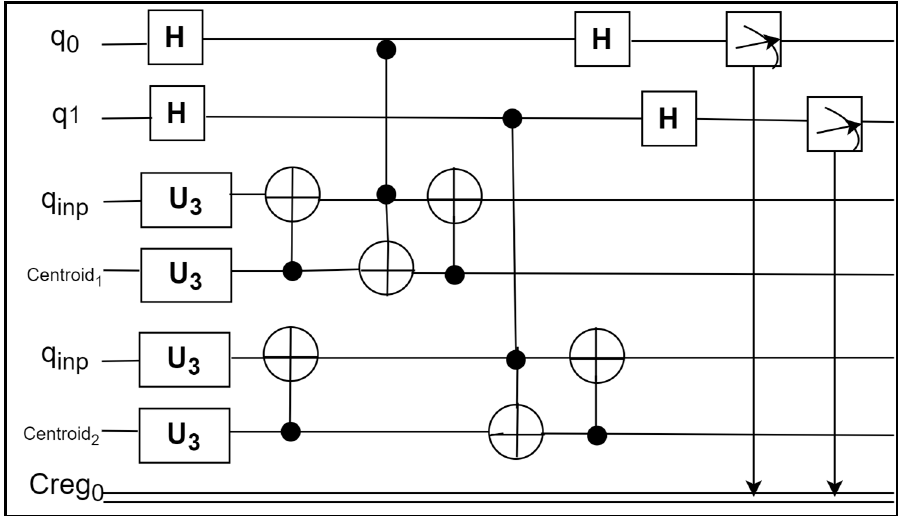
Figure 4. Using the Hadamard gate on the first qubit, the creation of the centroid distance estimate calculated the distance between the centroid and the datapoints using the SWAP test, then we performed the measurement to obtain the output. q 0 and q 1 are the quantum registers in superpostition. q inp is the quantum register which is used to encode the classical input datapoints. Centroid 1 and Centroid 2 quantum register encode the centroid value (cluster center), Creg 0 is the classical register.